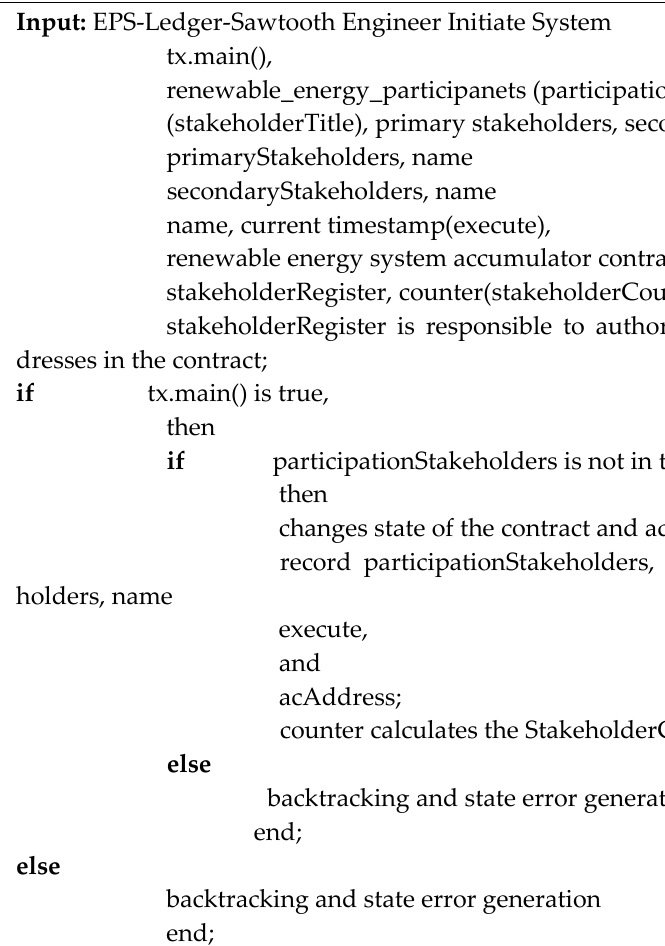
Algorithm 1: Registration of Participating Stakeholders (register()), (registration of the participating stakeholders and validate their roles).